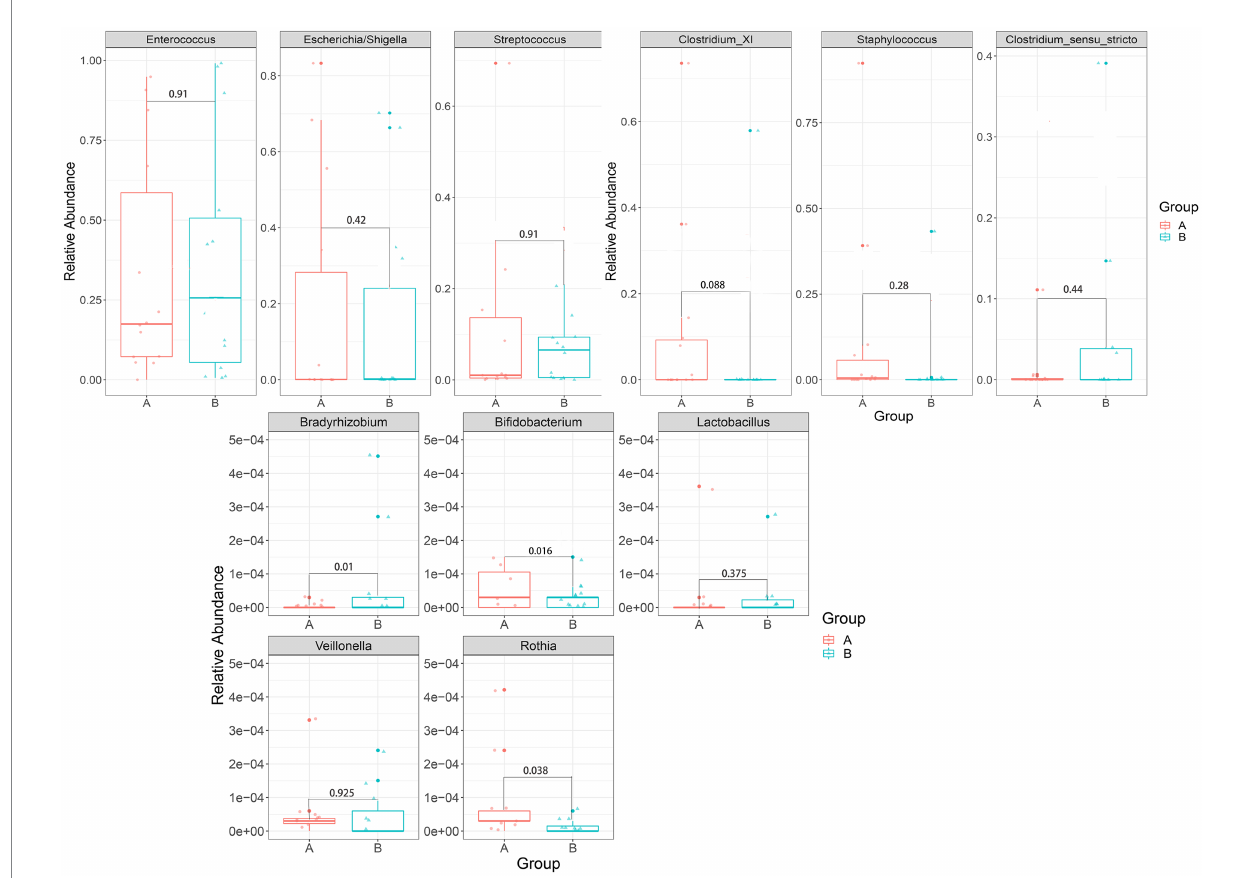
FIGURE 5 Differences in relative abundance between the two groups at the genus